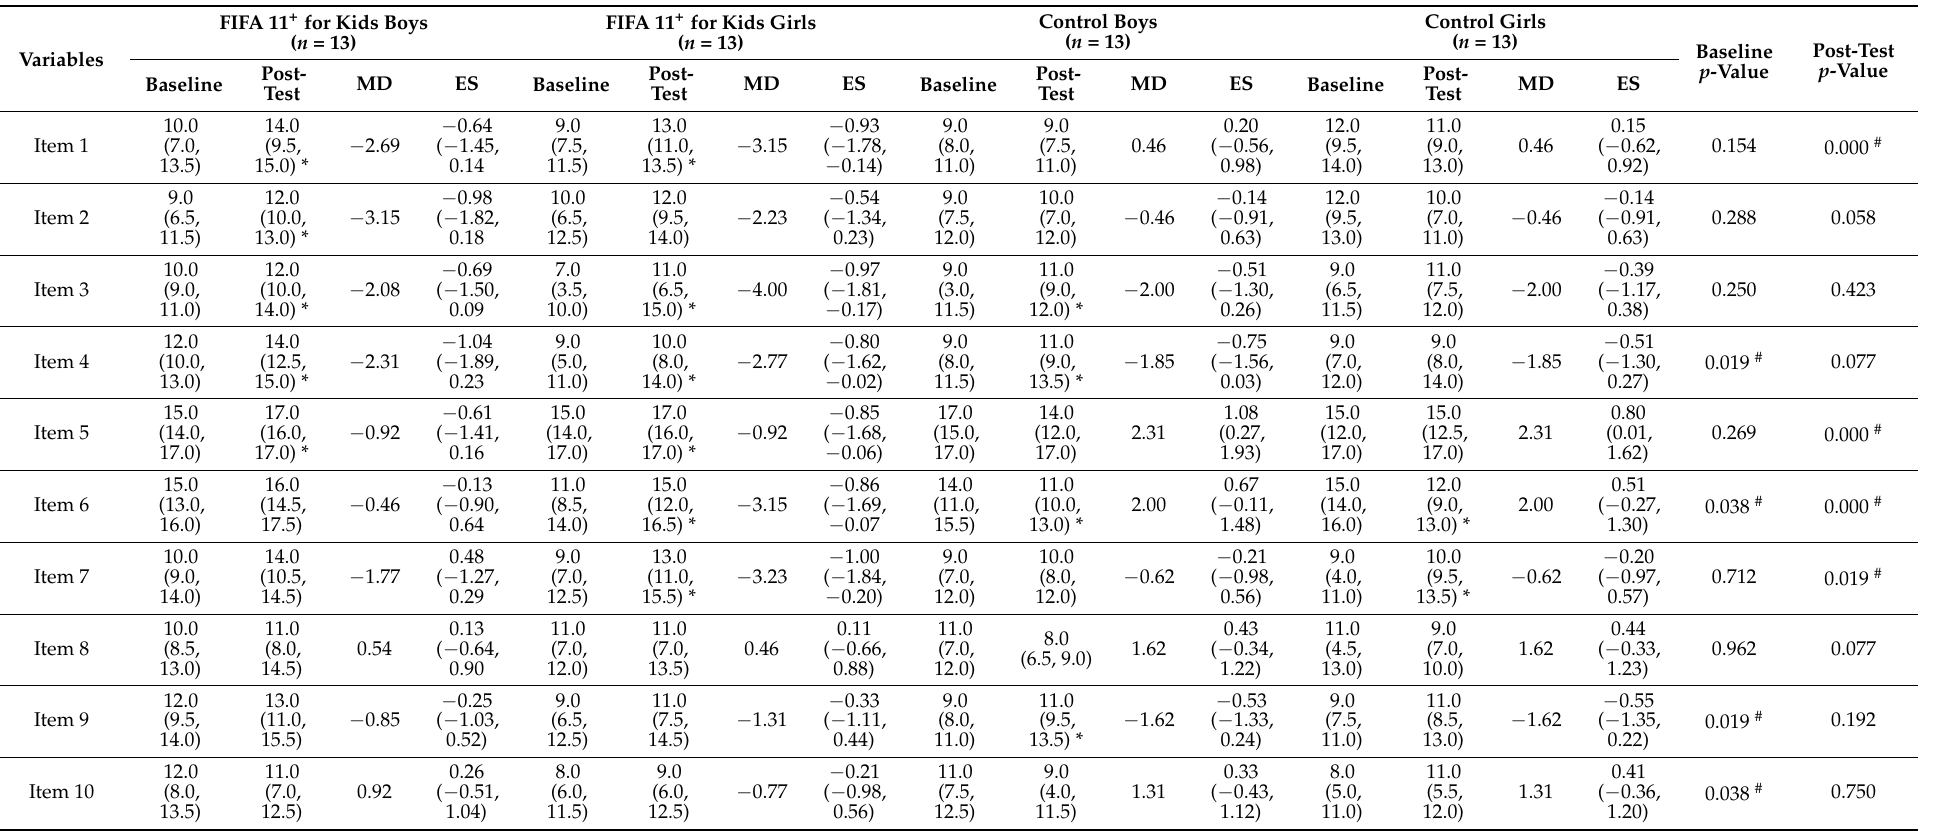
Table 2. The Attention Scale for Elementary School Children test items scores before and after the interventional